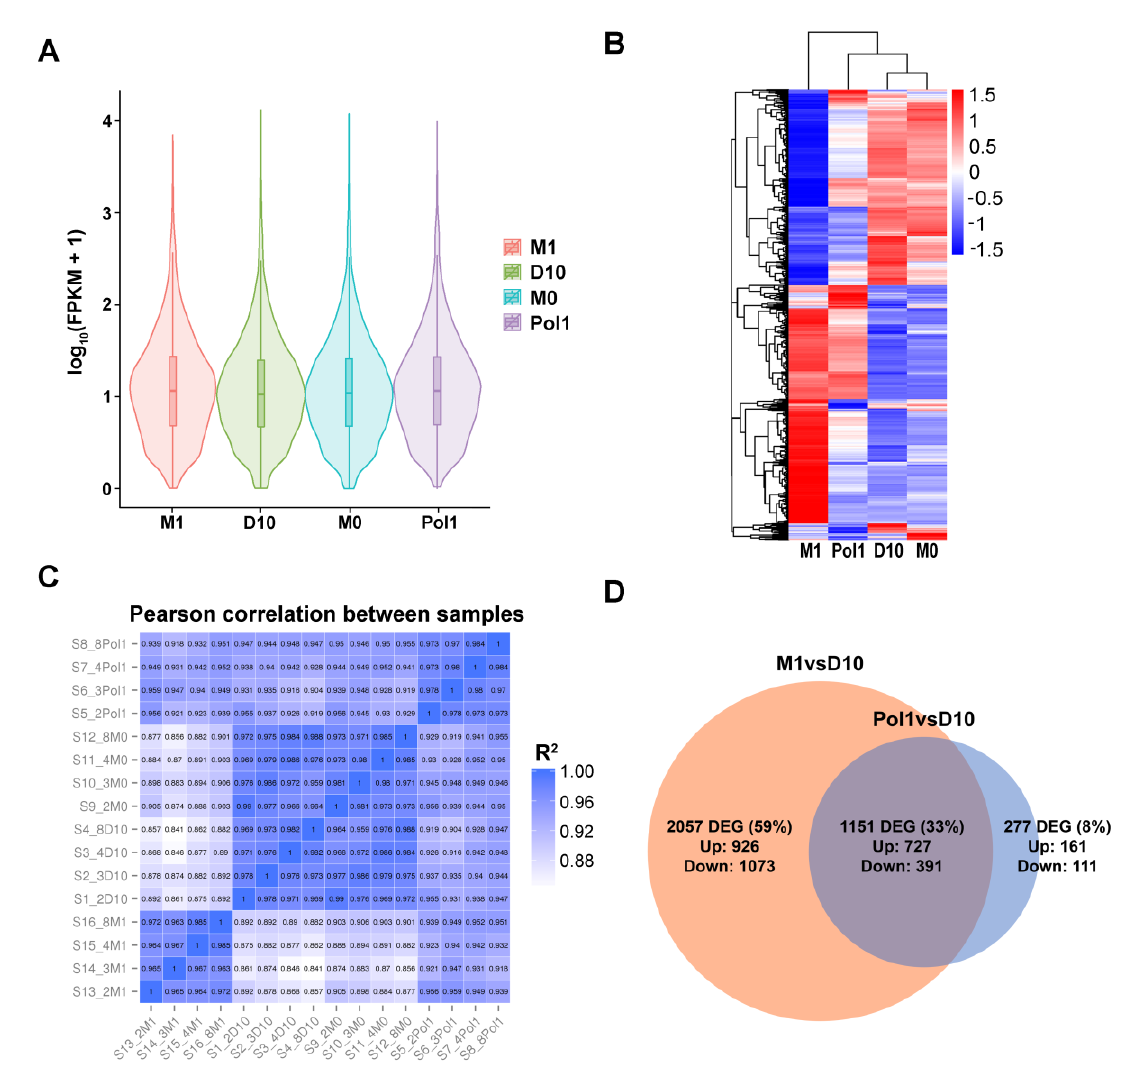
Figure 2. RNAseq overview and quality control. Macrophage-derived inflammatory conditioning of MSCs results in gene expression changes. ( A ) A violin plot shows that the distribution of the level of gene expression is similar across conditions, indicating no abnormalities in the dataset. x -axis represents the four conditions, and the y -axis represents the mean level of gene expression. Each violin has five statistical magnitudes (max value, upper quartile, median, lower quartile and min value). The violin width shows the gene density. ( B ) Cluster analysis of differentially expressed genes. The log10(FPKM+1) was the unit used for clustering and color scaling. Red denotes genes with high expression levels, and blue denotes genes with low expression levels. The hierarchical tree on the left indicates the relationship between clusters of genes with similar patterns of gene expression. ( C ) Correlation matrix showing the level of similarity in gene expression pattern between samples. The color grading is based on the value of the square of Pearson correlation coefficient. The axes show the sample names (S1 to S16), including the condition they represent. ( D ) Venn diagram comparing the differentially expressed genes (DEG) resulting from the comparisons M1vsD10 and Pol1vsD10. The overlap of both sets represents the genes expressed in both M1 and Pol1 conditions compared to D10. Abbreviations : FPKM: fragments per kilobase of transcript sequence per millions base pairs sequenced; D10: MSCs conditioned with DMEM medium with 10% fetal bovine serum; M0: MSCs conditioned with M0CM; M1: MSCs conditioned with M1CM; Pol1: MSCs conditioned with pro-inflammatory polarization